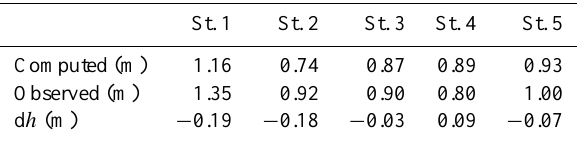
Fig. 4. A inundated depths after